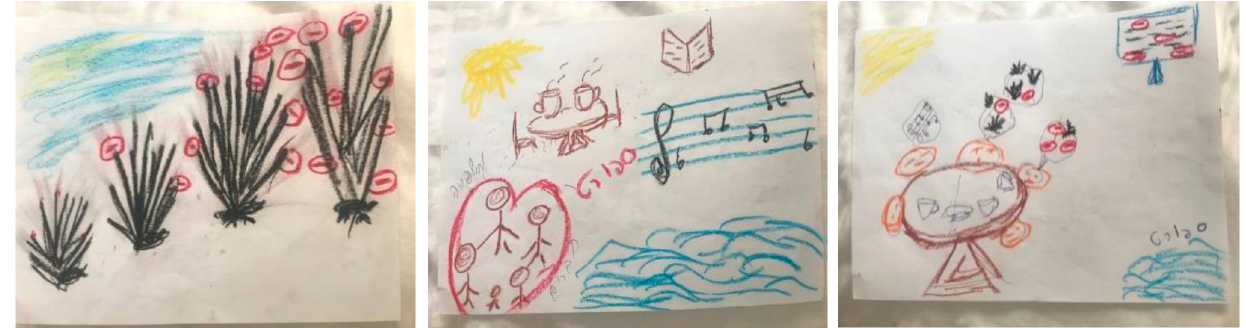
Figure 1. Decreasing the size of the stress image and giving more place to the resources within the integrated drawing.